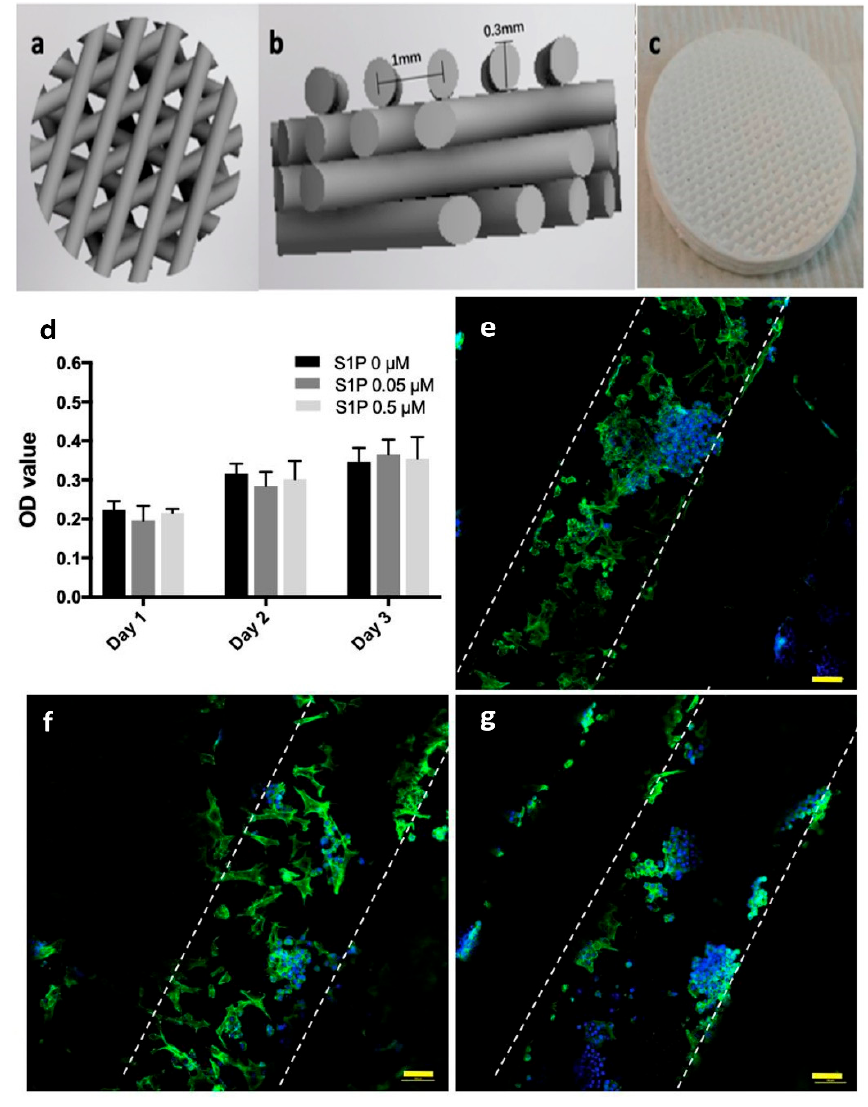
F igure 11. ( a – c ) Illustrates the schematic of 3D printed scaffold. ( d ) showing that there is no noticeable difference on viability of bone marrow-derived mesenchyme stem cells (BMSC) cells on additively manufactured scaffolds coated with S1P among the control group (S1P 0 mM) and other groups after 3 days. ( e ) S1P 0 mM group, ( f ) S1P 0.05 mM group, ( g ) S1P 0.5 mM group. Dyed blue area representing the cell nuclei and green area showing cytoskeletons. Edge of filaments showed by dotted lines